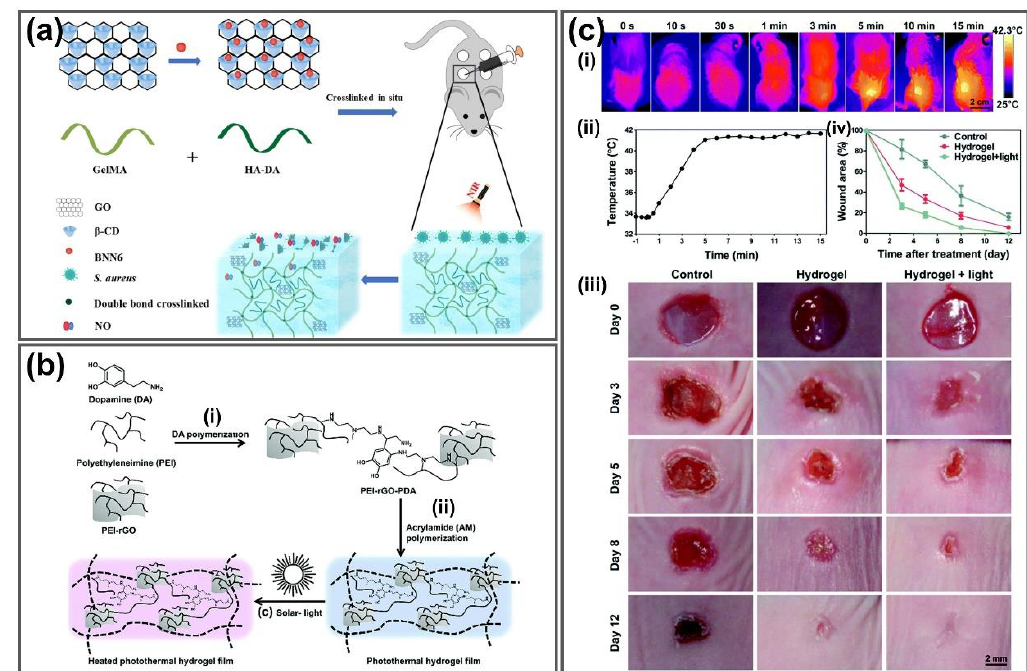
Figure 9. ( a ) Illustration of fabrication of GO-βCD-BNN6 hydrogels as an NIR-mediated NO release nanovehicle for bacteria-infected wound healing. Adapted with permission from [143] . ( b ) Preparation process of photothermal hydrogel film from (i) the polymerization of DA in the presence of PEI and PEI-rGO to (ii) polymerization of acrylamide and heat generation by this hydrogel film under solar light exposure. ( c ) In vivo wound healing effects of photothermal hydrogel film on mice after 12 days of treatment. (i) thermal images of GGel-treated mice under solar light, (ii) photothermal heating curve of wound site during 15 min exposure, (iii) skin wound photographs after 12 days treatment, (iv) wound area measurements of mice after treatment of different groups. Adapted with permission from [145] .